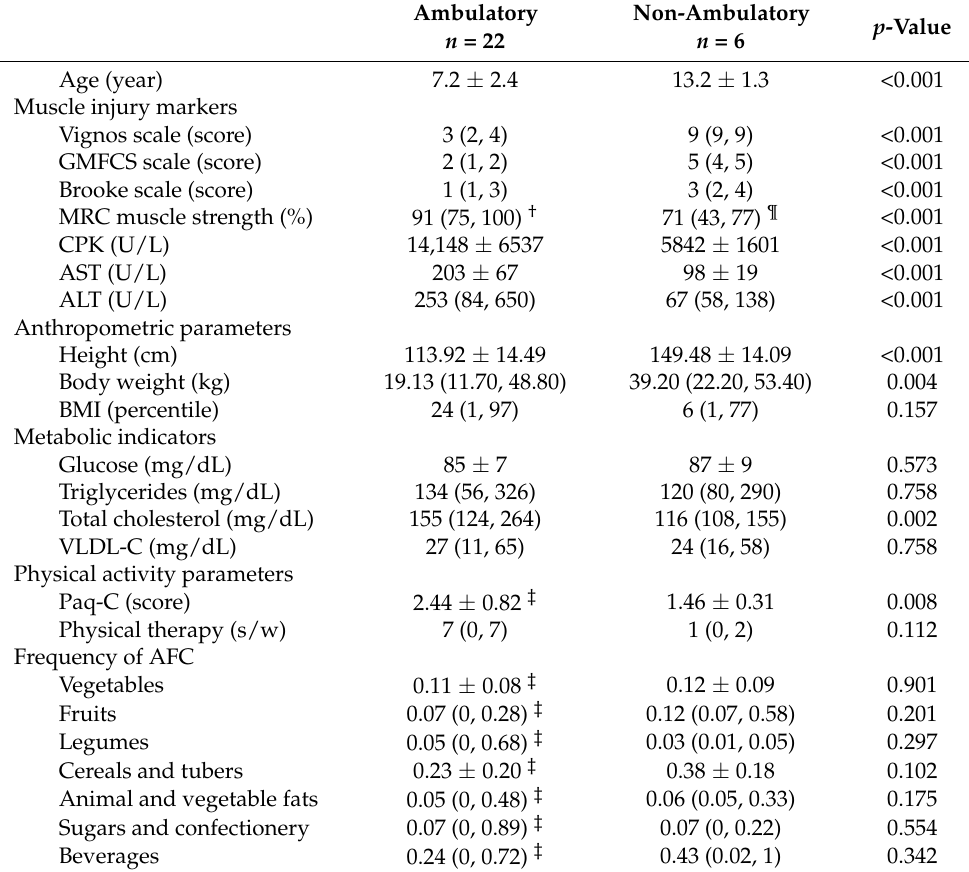
Table 1. Characteristics of ambulatory and non-ambulatory DMD